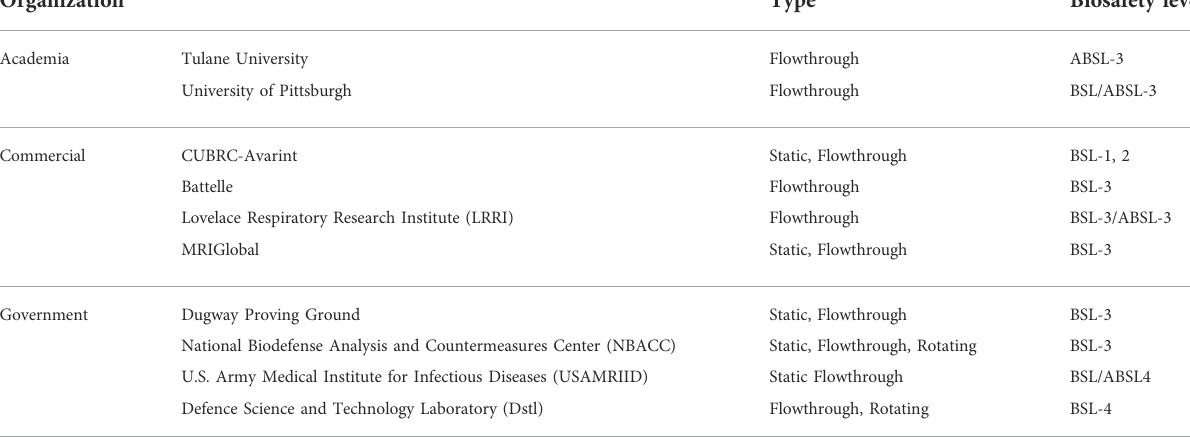
TABLE 1 Representative set of aerosol test chambers. The list was derived from open source material.